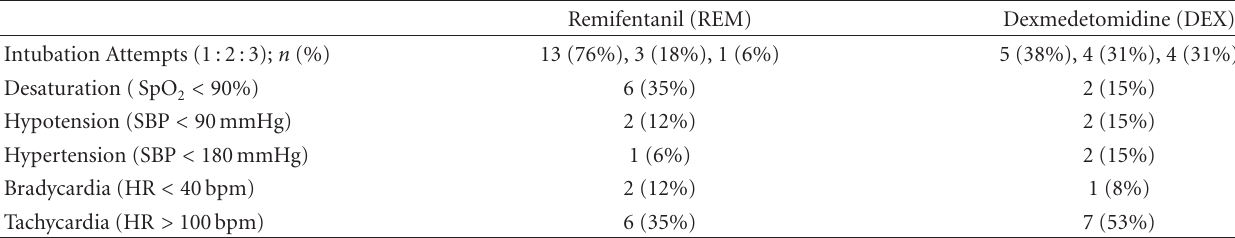
Table 4: Adverse e ff ects observed in patients between the two groups. Data includes intubation attempts, desaturation (SpO hypotension, hypertension, bradycardia, and tachycardia.